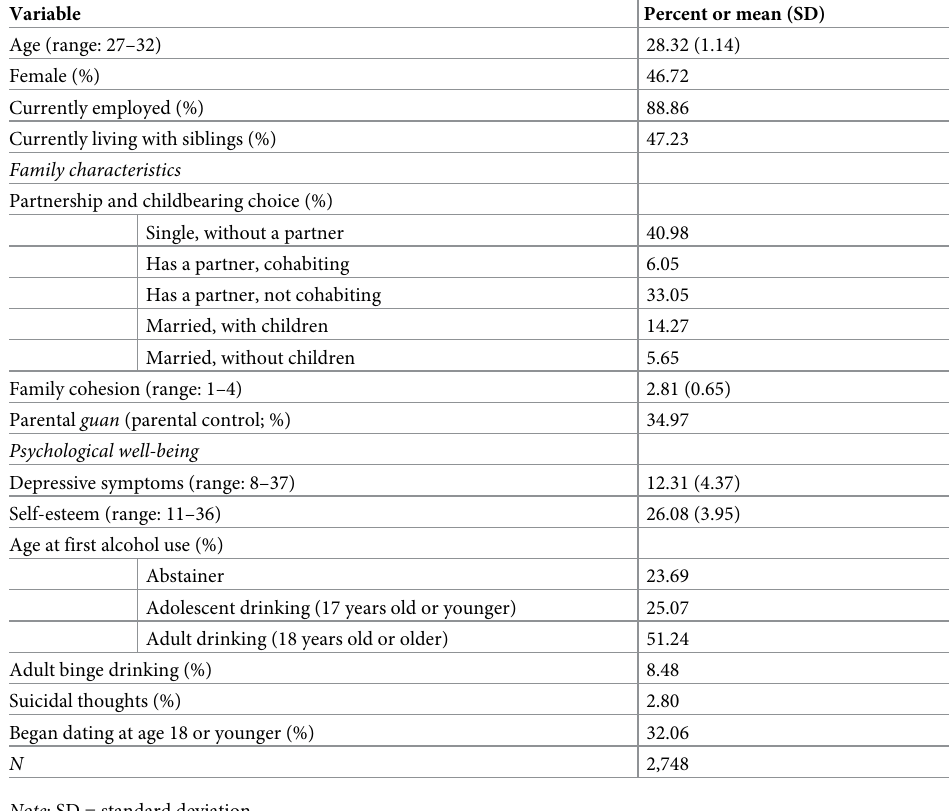
Table 1. Descriptive characteristics of the sample of young adults [percent or mean